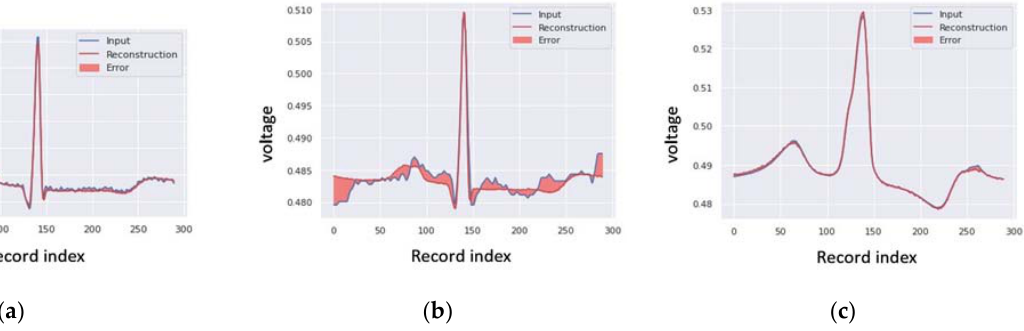
Figure 10. Reconstruction and testing results for: ( a ) MIT-BIH training data tested against the NSR Autoencoder; ( b ) Savvy ECG data tested against the NSR Autoencoder; ( c ) PVC heartbeat from the INCART database tested against the PVC Autoencoder.